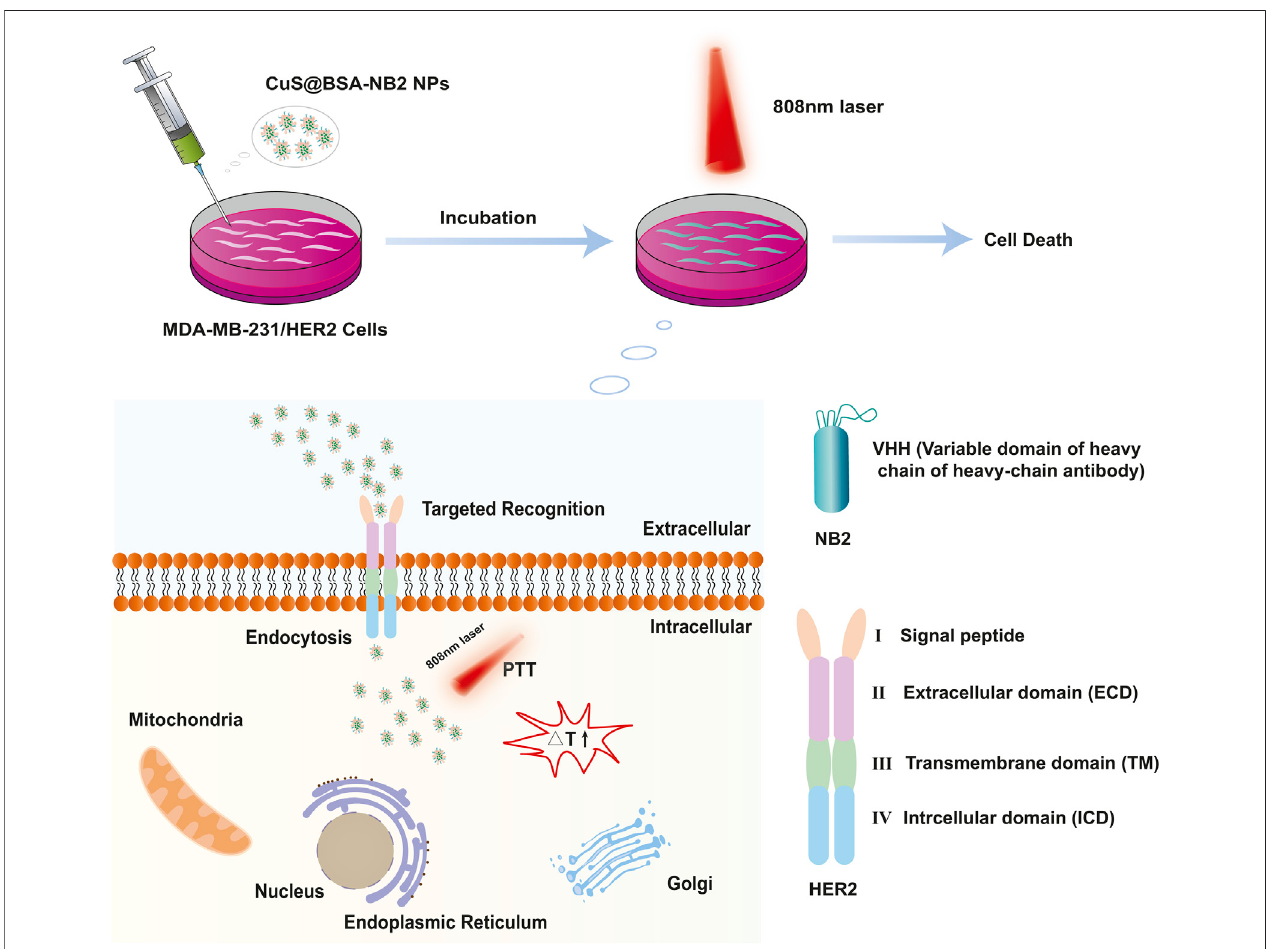
FIGURE 1 | Schematic diagram of CuS@BSA-NB2 NPs targeting HER2 for photothermal therapy in MDA-MB-231/HER2 cells.